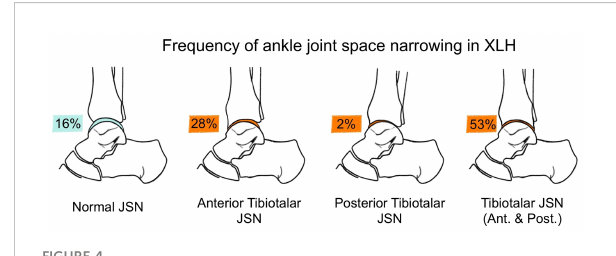
FIGURE 4 Frequency of mild to severe JSN and normal joint space in the tibiotalar joint in patients with XLH 34